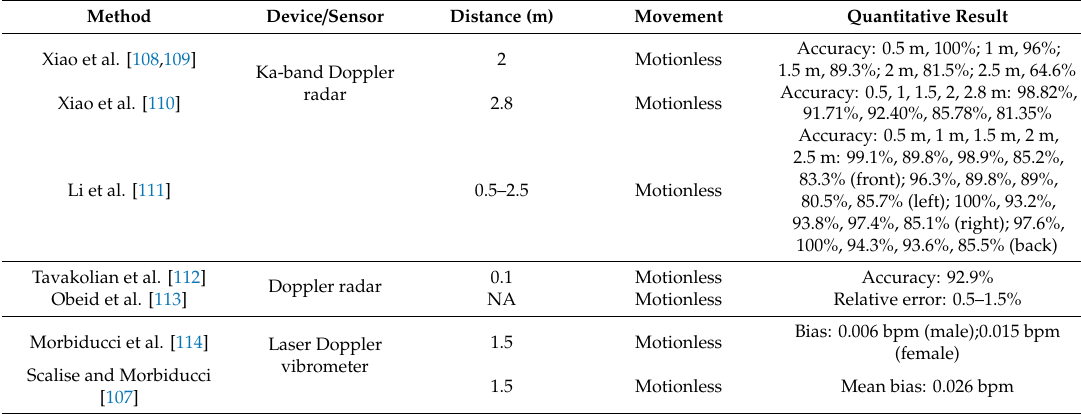
Table 10. Summary of Doppler radar and laser measurements for HR